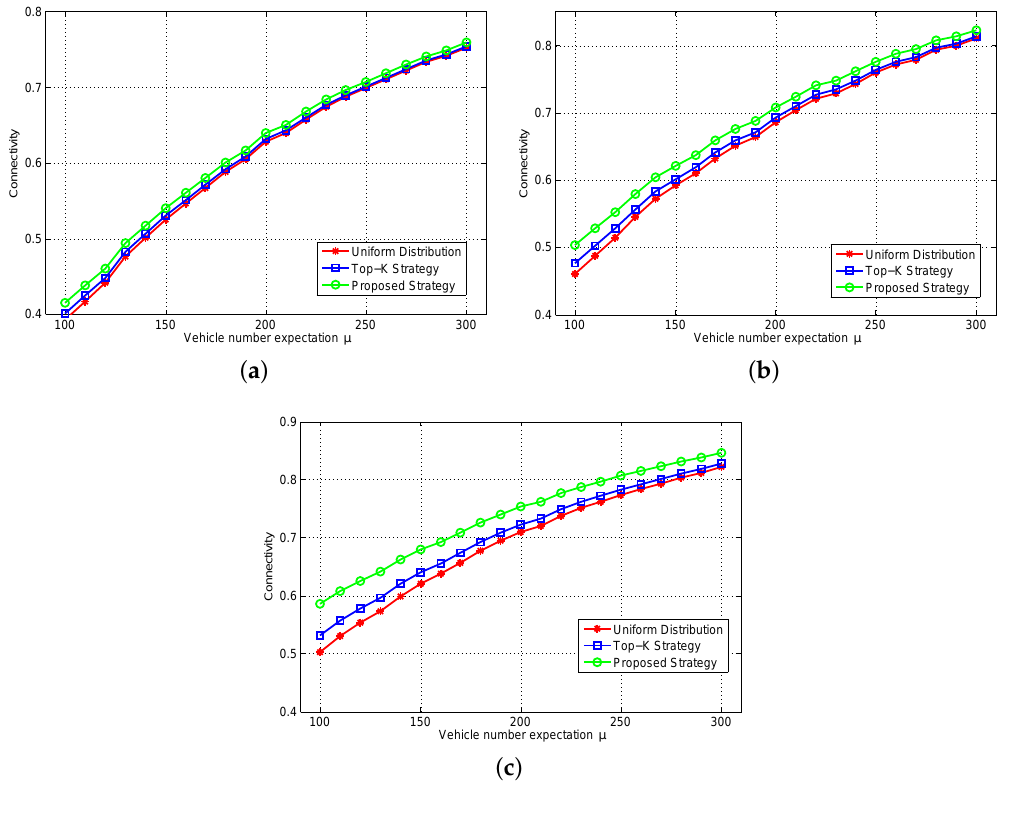
Figure 9. Connectivity under different allocation strategies. ( a ) number of RSUs m = 10; ( b ) number of RSUs m = 20; ( c ) number of RSUs m =